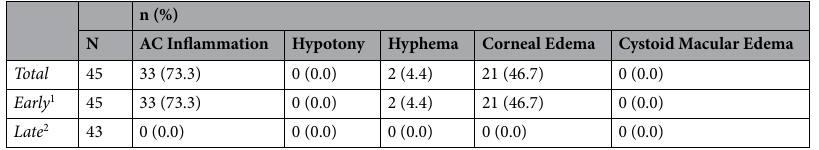
Table 6. Complication Rates. N = number of patients; n = total number of patients at specific follow-up time; AC = anterior chamber. 1 Complications present up to 3 months postoperatively. 2 Complications present after 3 months